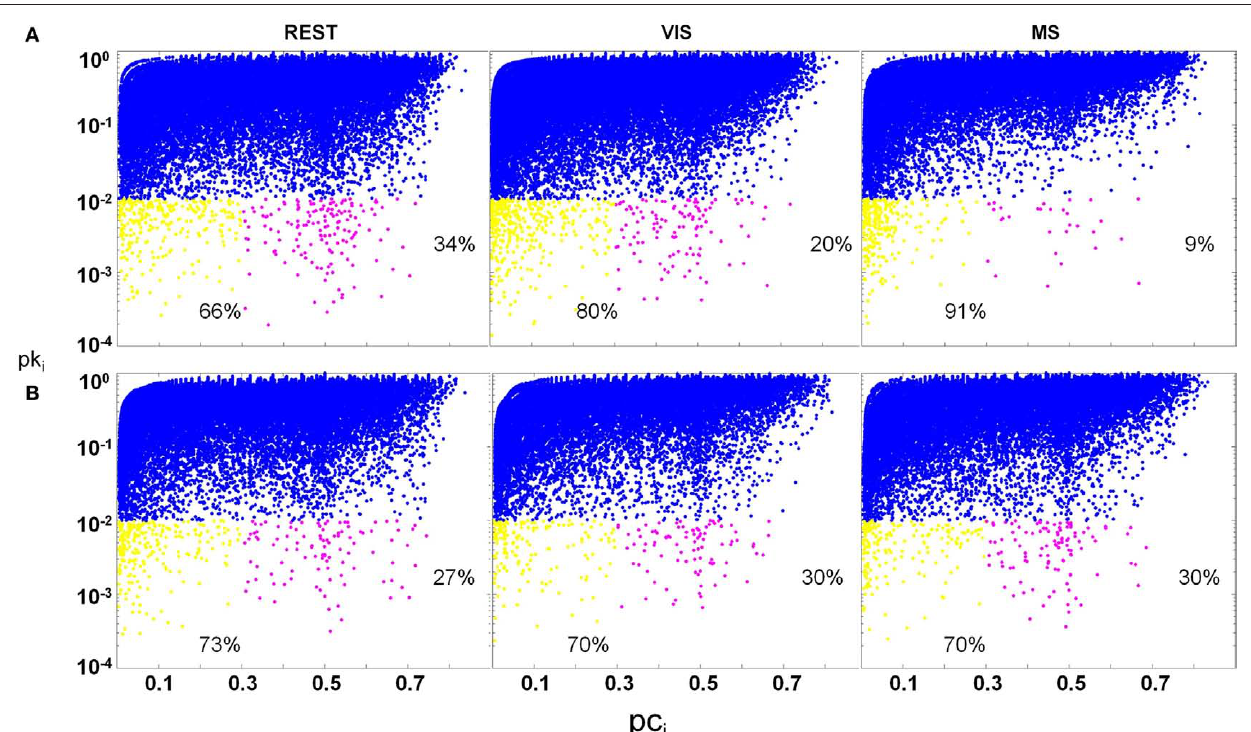
task was found for the proportion of hubs across condition. Connectors Figure 11 | Change in hub proportions across task. Hubs are defined as significantly decreased across task, with multisensory (MS) having the lowest having a pk ≤ 0.01. Provincial (yellow; pc ≤ 0.3) and connector (magenta; i i proportion. In contrast, the proportion of provincial hubs increased across task, 0.3 < pc ≤ 0.75) hubs as well as non-hubs (blue; pk > 0.01) are plotted across i i with rest (REST) having the lowest proportion. In the occipital module (B) , no task condition. In both auditory and visual modules, there was no change in the main effect of condition was found on the proportion of either proportion of non-hubs across task. In the auditory module (A) , a main effect of